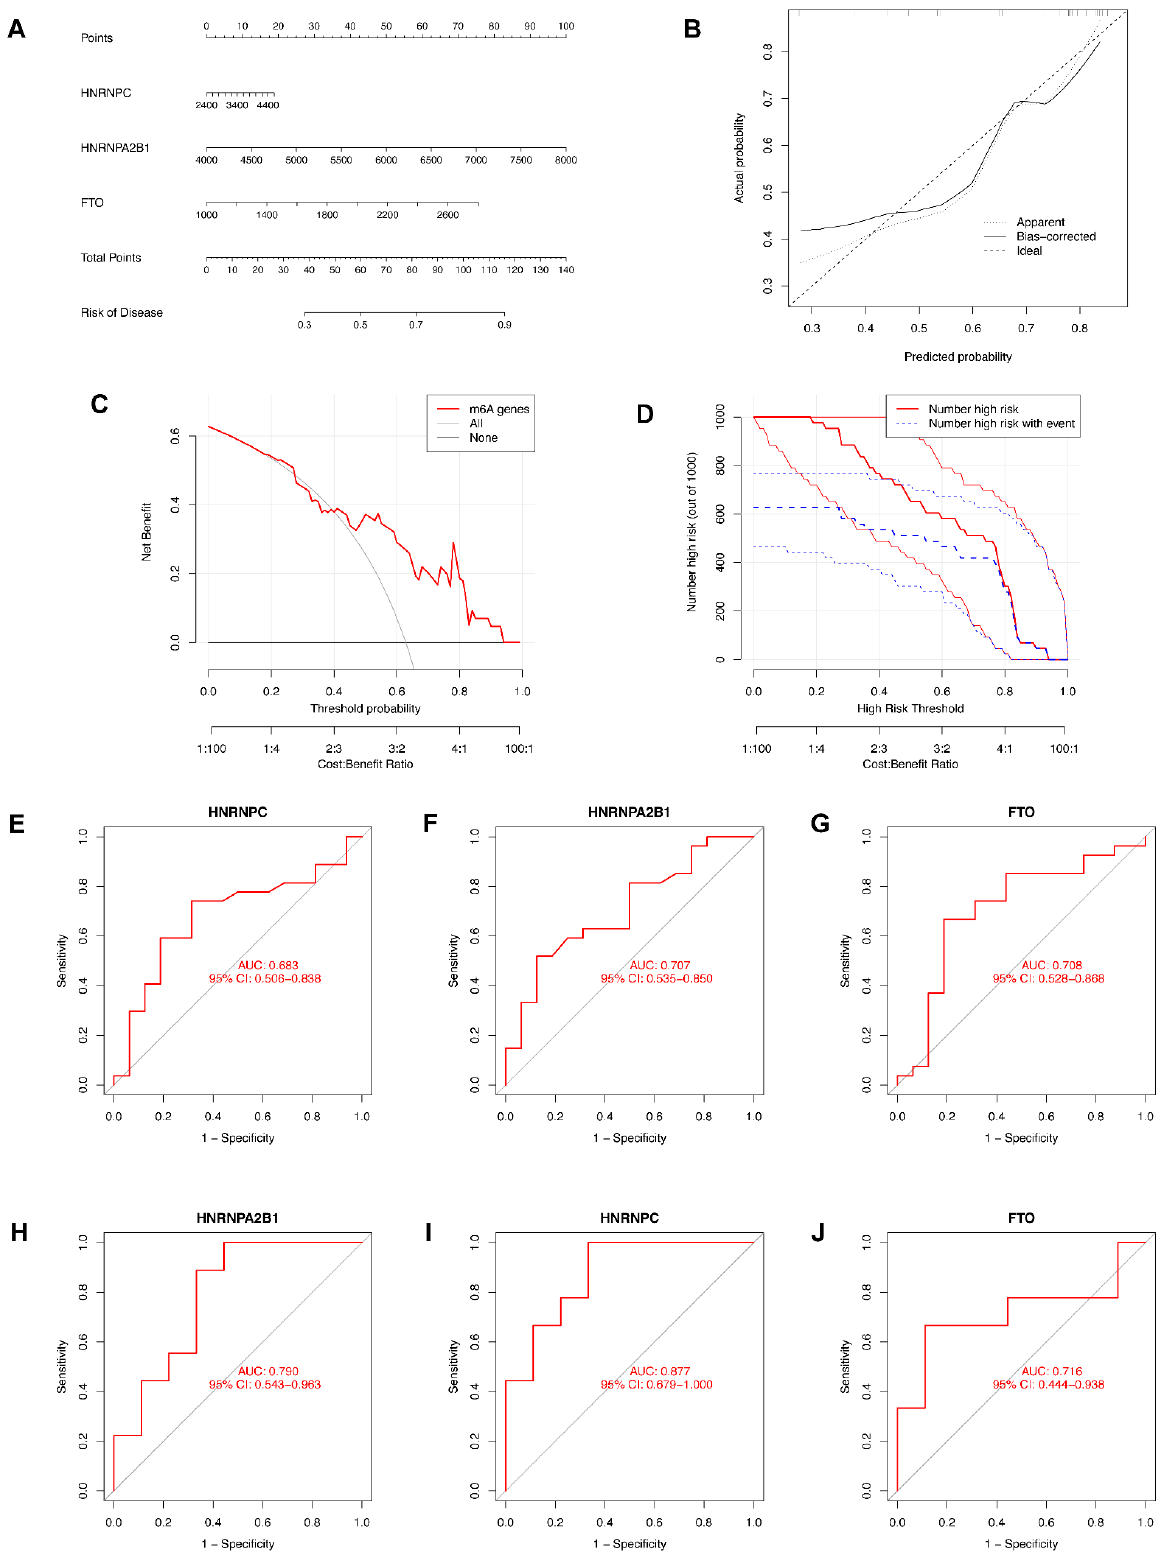
Figure 5. Construction of the nomogram model and the ROC curve. ( A ) The nomogram model based on the candidate genes. ( B ) The calibration curve of the nomogram model. ( C ) The DCA curve of the nomogram model. ( D ) The clinical impact curve of the nomogram model. ( E – G ) ROC curves of candidate genes based on GSE6364. ( H – J ) ROC curves of candidate genes based on GSE11691 for